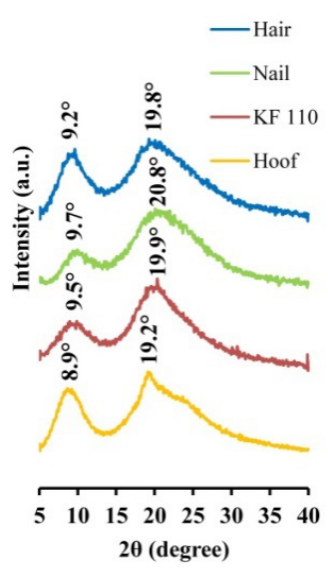
Figure 4. X-ray di ff raction patterns of human hair, nail, KF-110 and bovine hoof Figure 4. X-ray diffraction patterns of human hair, nail, KF-110 and bovine hoof samples.